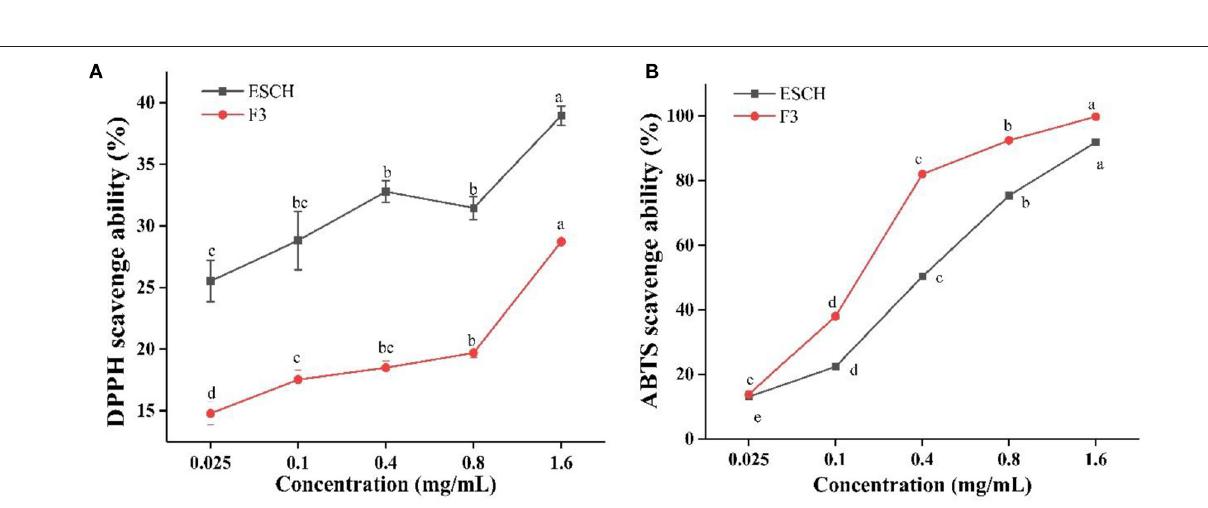
Frontiers in Nutrition |